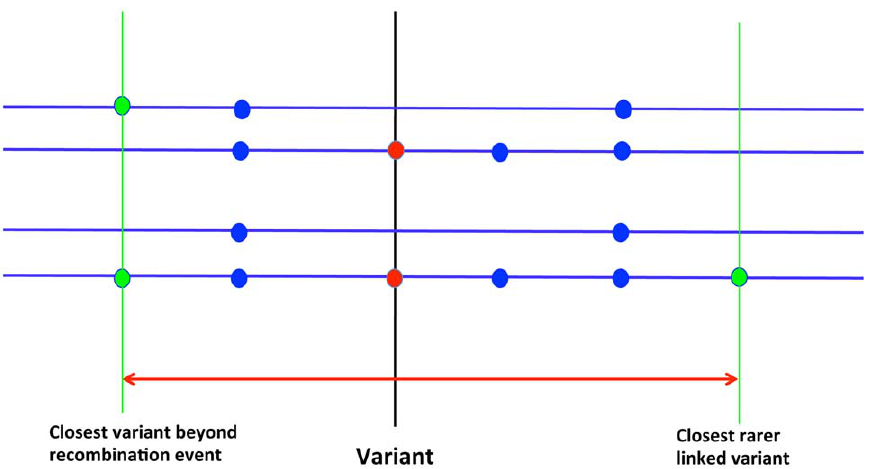
Figure 3. Cartoon presentation of the NC statistic. The NC statistic aims to capture the length of the haplotype carrying a variant. For a given variant (called the index variant, shown in the middle of the figure), the value of the NC statistic is the base-10 logarithm of the sum of physical distances measured up-stream (5 9 direction) and down-stream (3 9 direction) from the index variant to the closest variant that is either beyond a recombination spot (example shown on the left) or is linked to the index variant but is rarer than the index variant (example shown on the right). The red arrow in the figure illustrates that sum of the two distances.